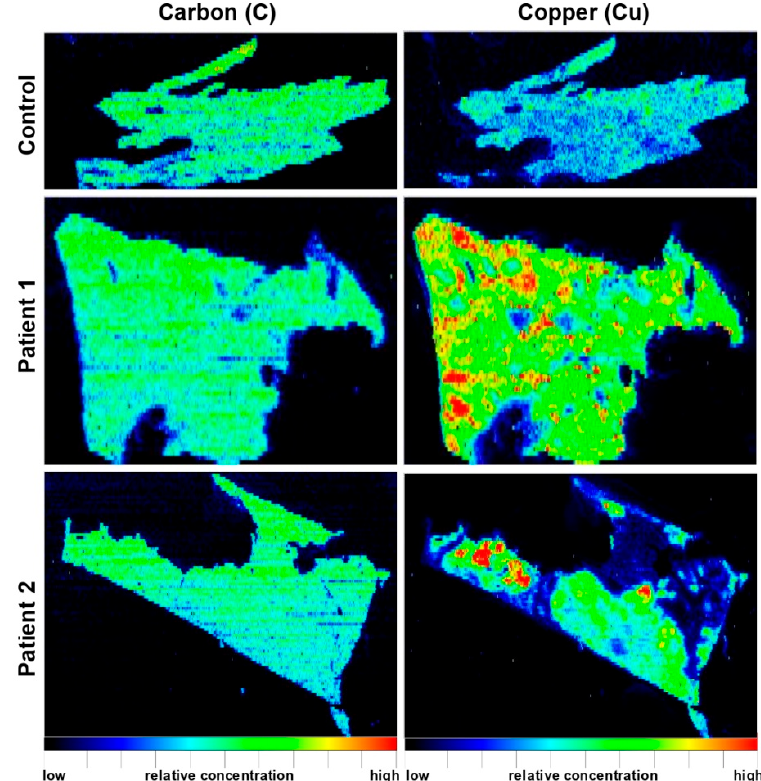
Figure 9. LA-ICP-MSI in human Wilson disease livers. Carbon (C) and copper (Cu) were imaged in biopsy samples taken from two Wilson disease patients (patients 1 and 2) and a healthy subject (control). Experimental details of this study are given elsewhere [39].